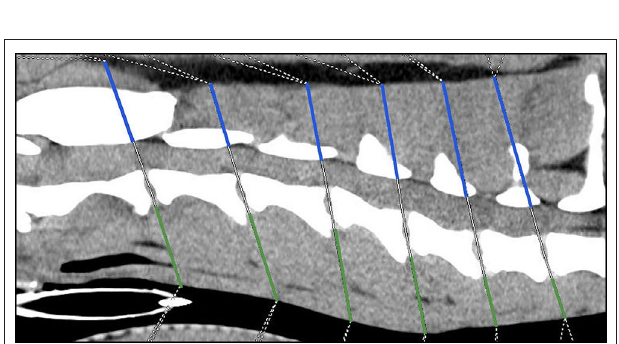
Ratios were determined as a convenient mechanism to express the magnitude of a relative